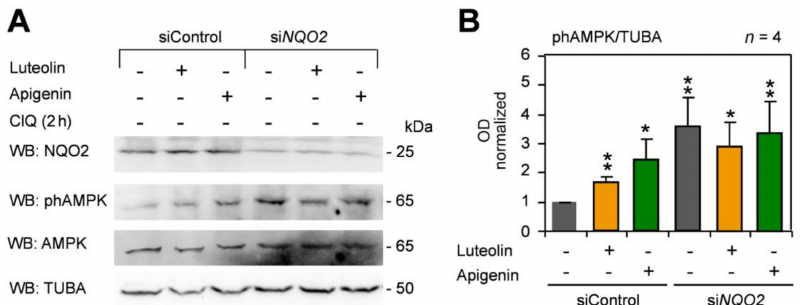
Figure 6. Silencing of NQO2 augments basic AMPK phosphorylation and inhibits the response to apigenin and luteolin. ( A ) HepG2 cells were transfected with a control siRNA and NQO2-specific siRNA, treated with flavones (10 µ g/mL) for 6h and analyzed by WB for phosphor-AMPK, total AMPK, LC3-II, and for the levels of NQO2 to verify the efficacy of anti- NQO2 siRNA. TUBA expression was analyzed as a loading control. ( B ) OD analysis (ratio to TUBA, normalized to vehicle-treated controls) of phAMPK signal as means +/ − SEM of n blots from n independent experiments. Statistical analysis: student T-test; * p < 0.05, ** p <